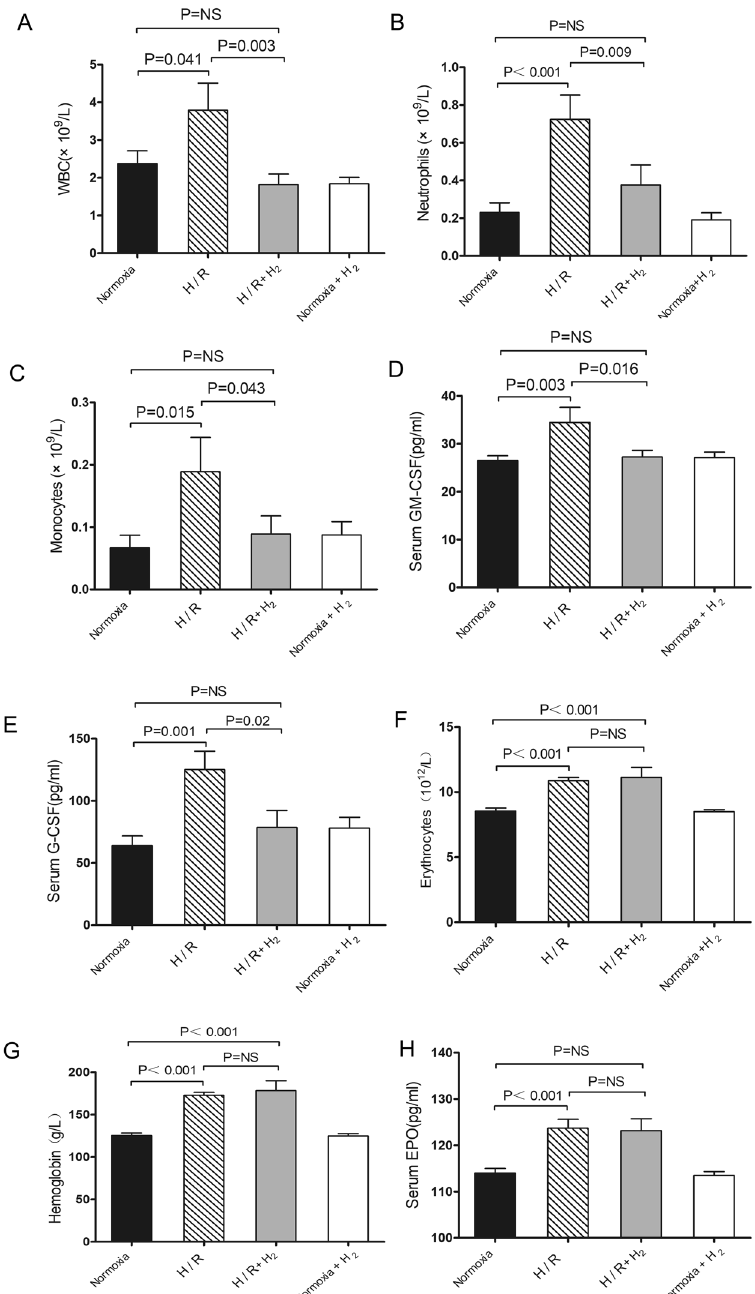
Figure 6. H 2 inhibits the H/R-induced increase in G-CSF and GM-CSF, but not H/R-induced up-regulation of the EPO-erythrocyte system. Mice were treated as in Fig. 1 (n = 10 in each group). Leukocytes ( A ), neutrophils ( B ), monocytes ( C ), erythrocytes ( F ) and hemoglobin ( G ) were assayed using an automatic blood analyzer. Serum levels of G-CSF ( C ), GM-CSF ( D ), and EPO ( H ) were assayed using commercial ELISA kits. Data shown are mean ± SEM. ns, not